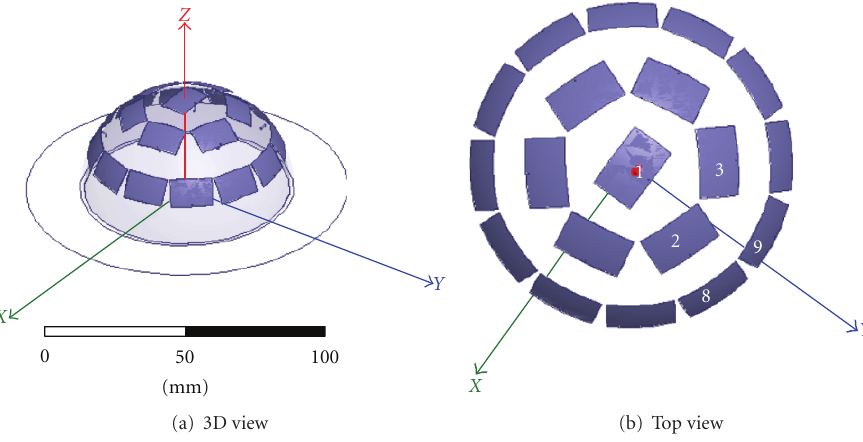
Figure 1: Arrangement of a hemispherical conformal array